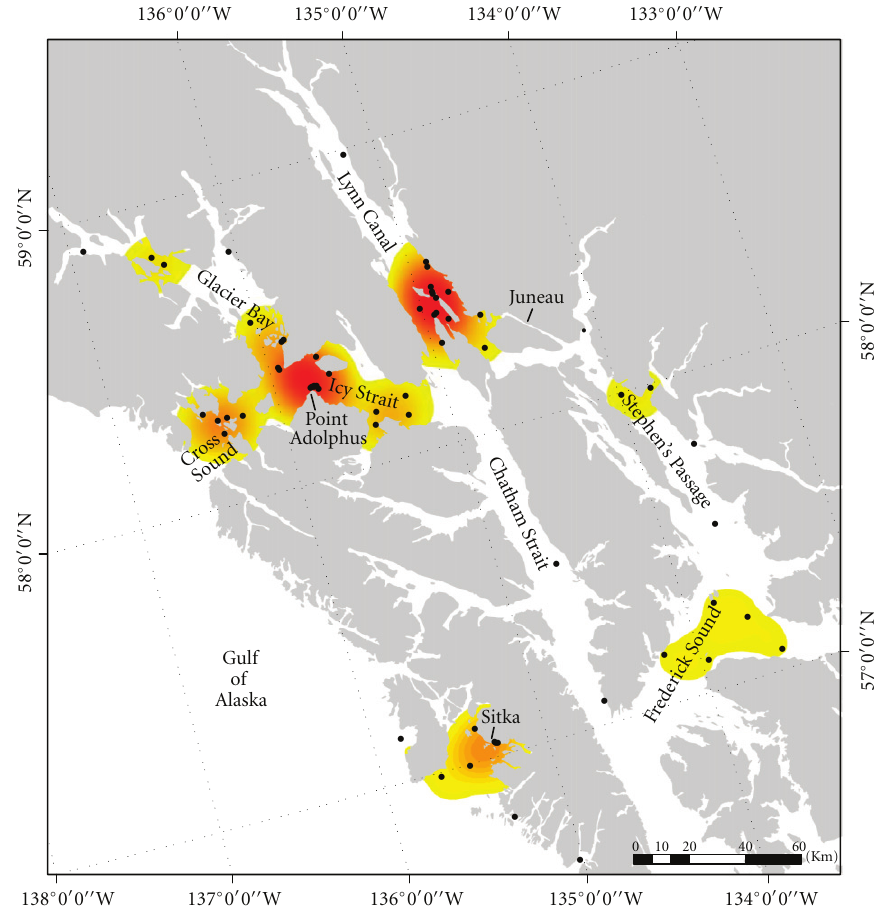
Figure 2: Whale-vessel collision hotspots in southeastern Alaska based on kernel density estimation. Yellow indicates moderate collision risk and red indicates higher collision risk. The locations of the collision reports used to create the map are